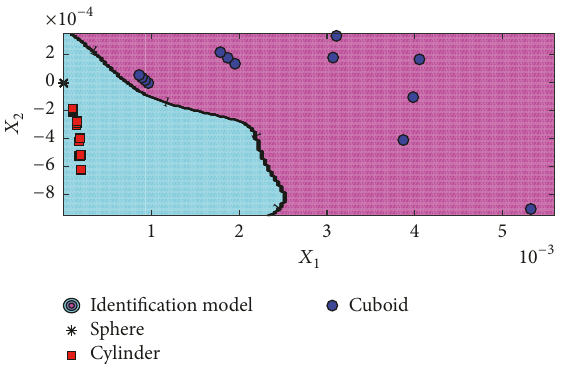
Figure 9: Identification model of the geometry properties trained by